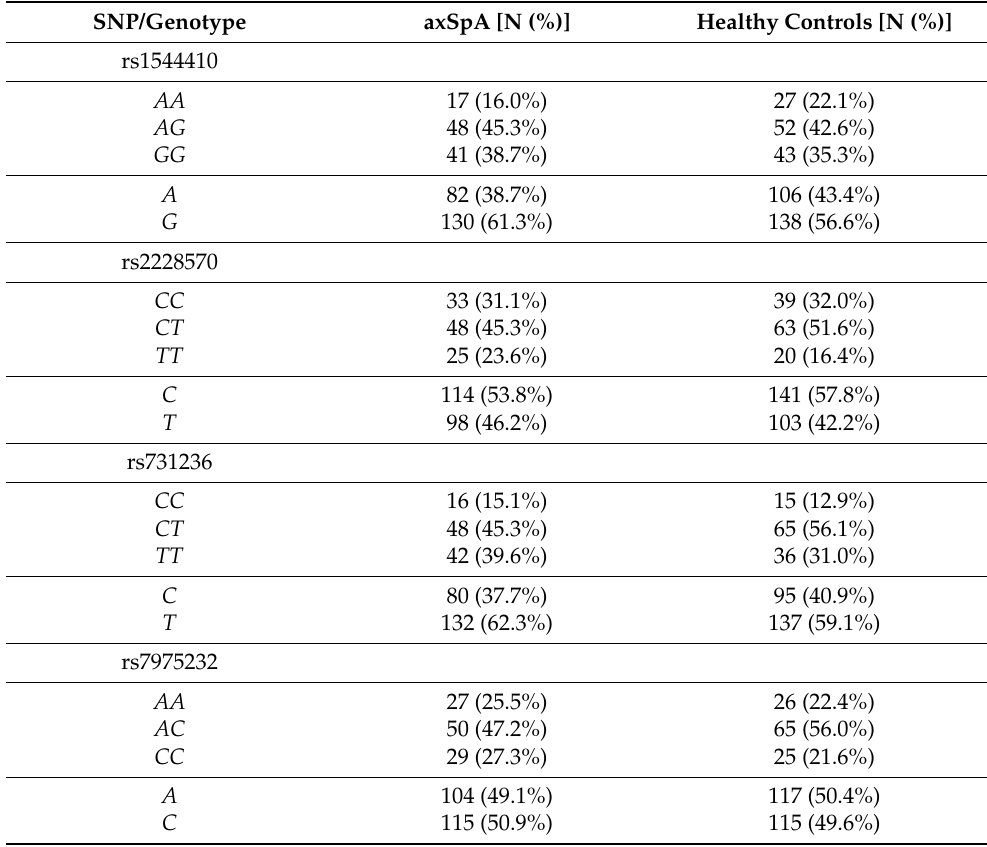
Table 2. Genotype and allele frequencies of studied VDR SNPs in patients with axial spondyloarthritis (axSpA) and in healthy controls.